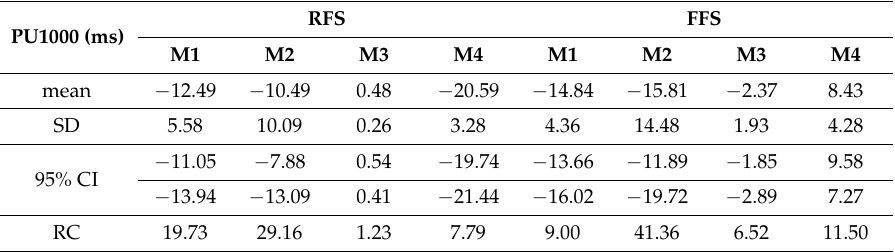
Table 4. Accuracy (mean) ± precision (standard deviation: SD), 95% confidence intervals (95% CI), and repeatability coefficient (RC) of foot strike detection methods (M1 to M4) for PUMA Speed 1000 (PU1000) and rearfoot (RFS) and forefoot strike (FFS) pattern.